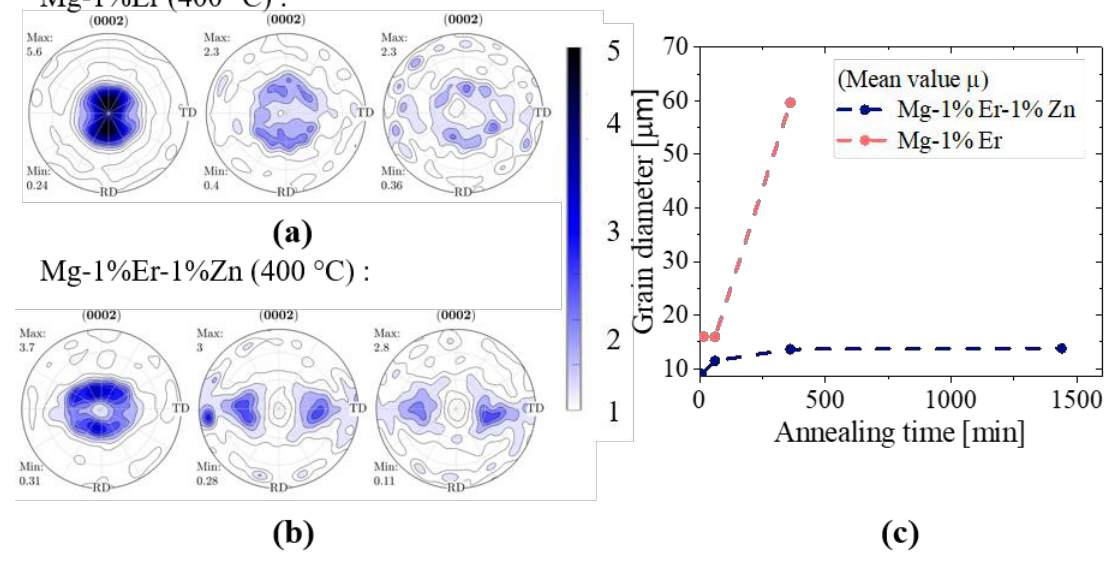
Figure 3. Texture evolution of binary and ternary ( a , b ) Mg-1%Er-(1%Zn) in the as rolled state and after annealing at 400 °C for 15 and 360 min, as well as the corresponding evolution of the mean grain diameter over time ( c ).